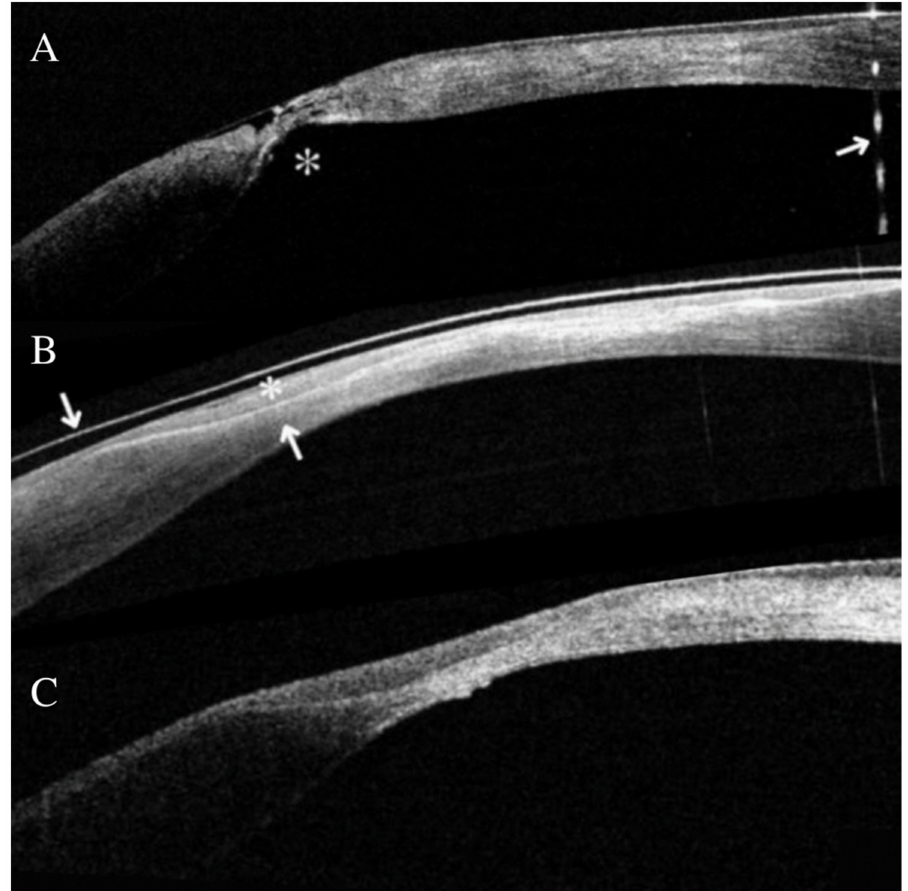
Figure 3. Patient number 3, right eye. ( A ) Anterior segment optical coherence tomography (AS- OCT) showing corneal thinning with residual stromal tissue (asterisk), Seidel positive. A reflex saturation beam artifact is visible as a dashed line (arrow). ( B ) The postoperative outcome at week 1. The therapeutic lens is seen above the corneal epithelium as a hyper-reflective band (arrow). The epithelium regrowth is indicated by a small asterisk and delimited by the Bowman’s membrane, visible as a hyper-reflective band (arrow). ( C ) The post-op outcome at 1 month shows a similar corneal appearance to week